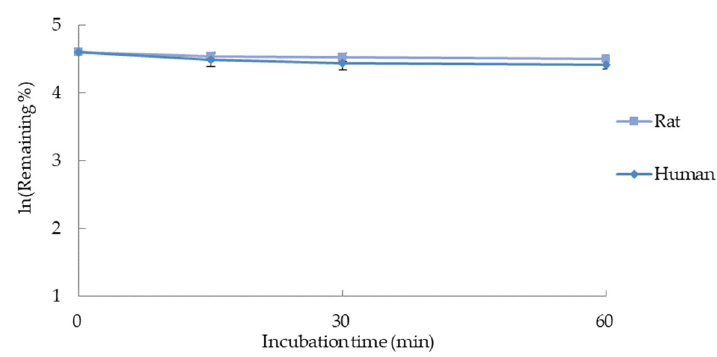
Figure 3. Metabolic stability of α -amanitin in rat and human liver microsomes.